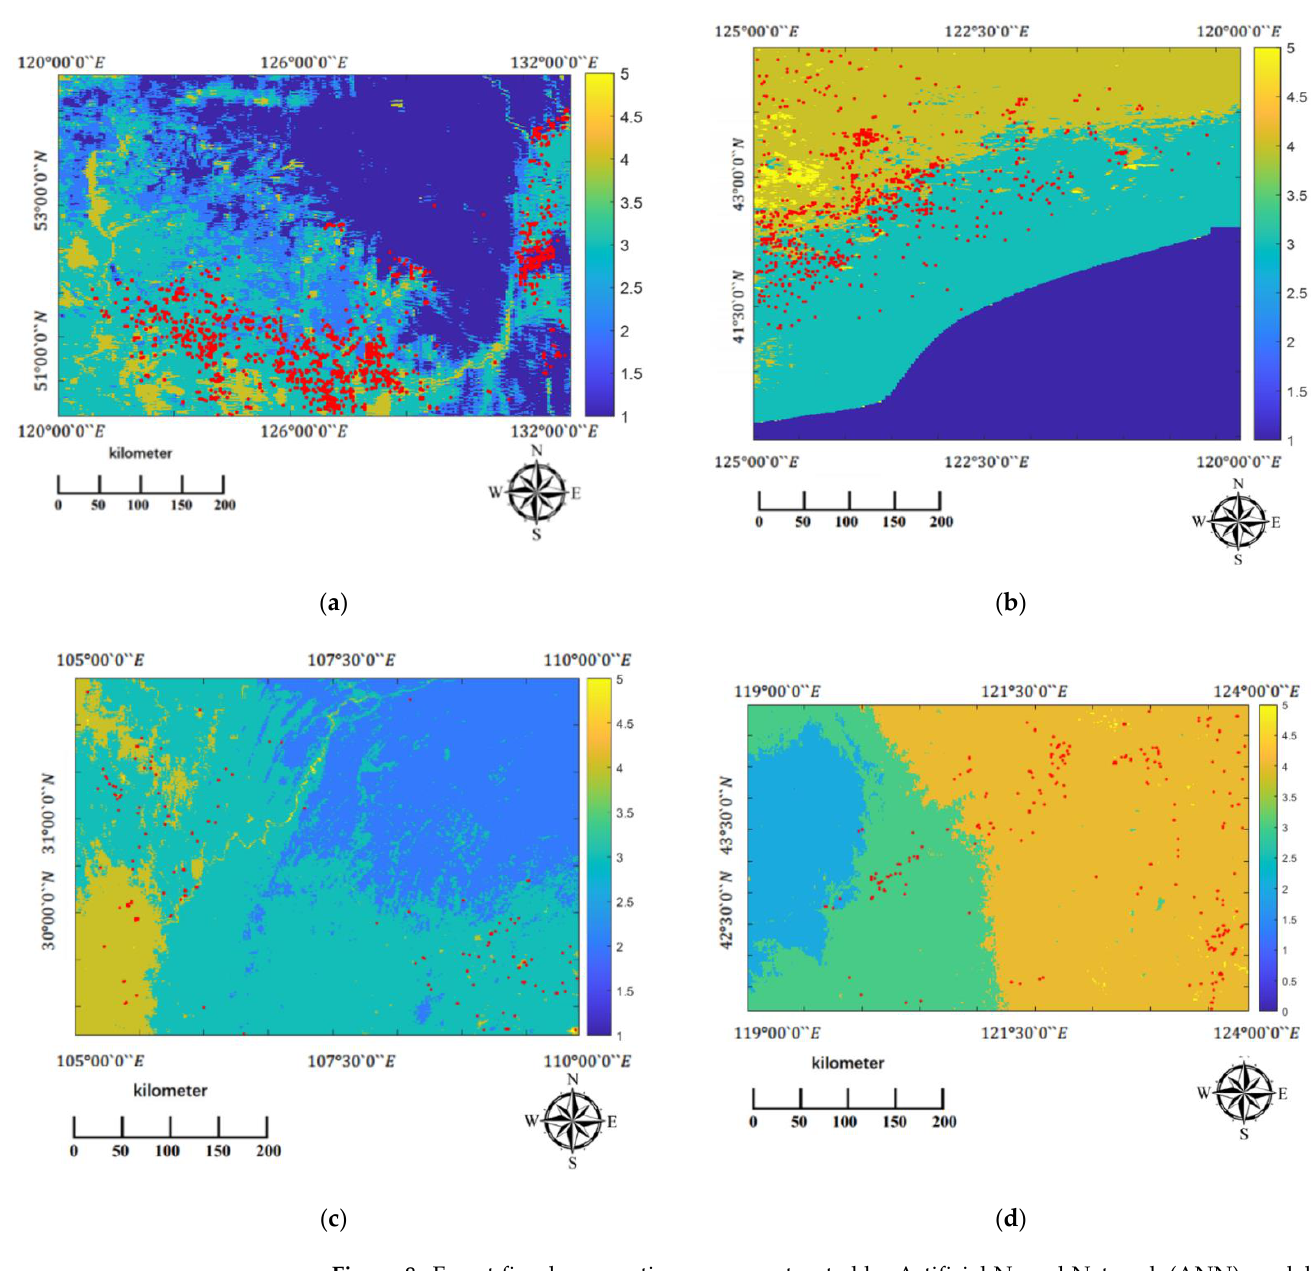
Figure 8. Forest fire danger rating map constructed by Artificial Neural Network (ANN) model: ( a ) forest area in the southern Greater Khingan Mountains; ( b ) forest area near Hulunbercity; ( c ) forest area near Chongqing city; ( d ) forest area near Tongliao city. The proportion of fire spots in the test set falling on each fire danger rating map es- tablished by the three different methods is shown in Figure 9a – d.